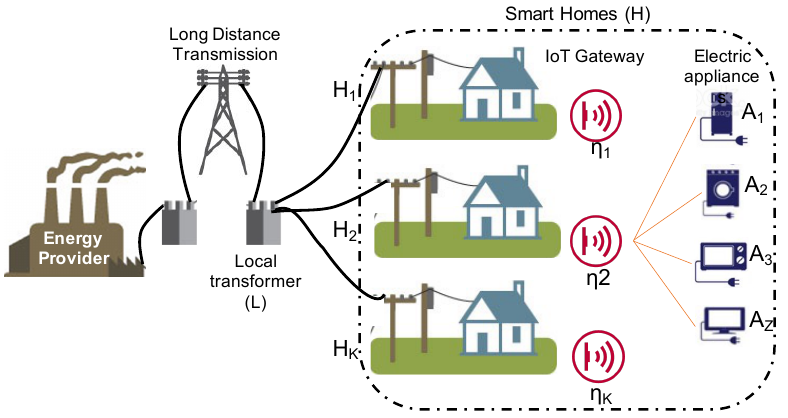
Figure 1. A system model linking the energy producer to the residential households at smart homes (where their electric appliances are connected to Internet of Things (IoT) gateways).